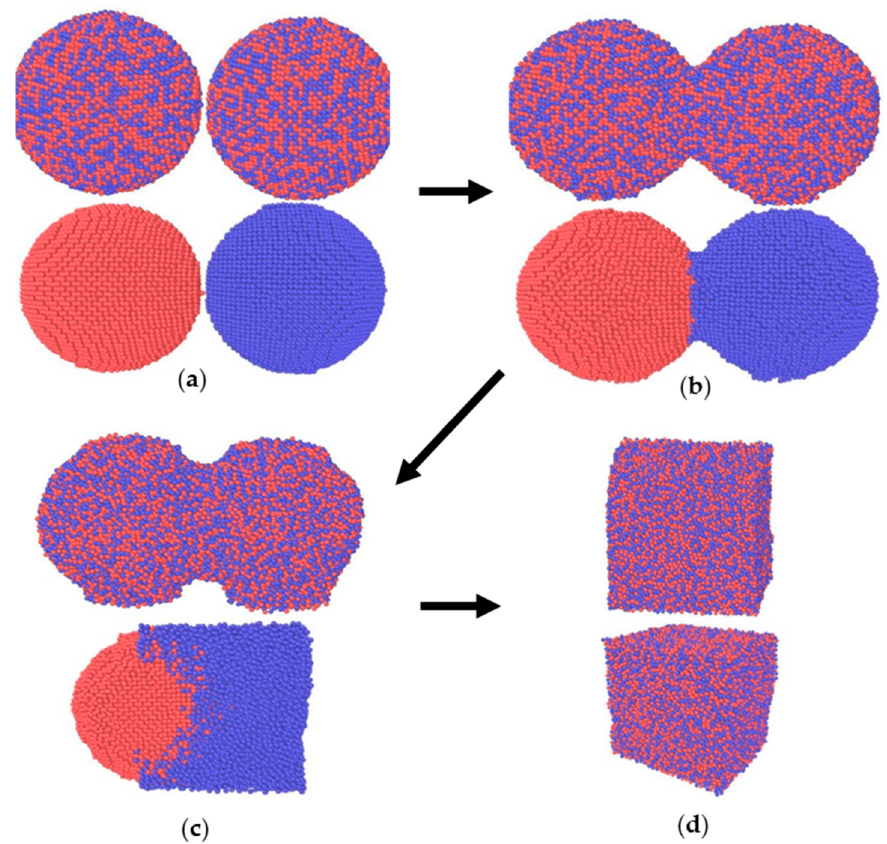
Figure 8. Melting and mass transfer of spherical alloy particles and elemental particles: ( a ) spherical particle model, ( b ) particles begin to melt, ( c ) particles move closer to each other, ( d ) completely melted and cooled to room temperature.